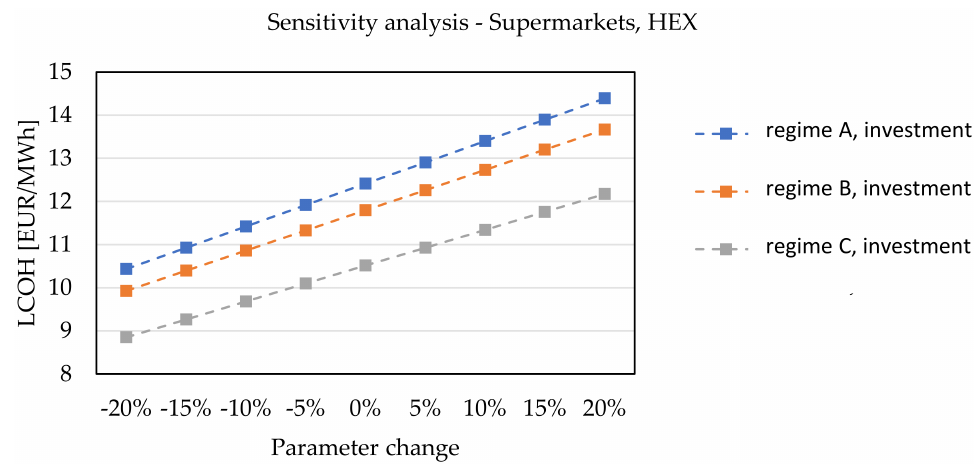
Figure 23. Sensitivity analysis for different DH network temperature regimes—supermarkets waste heat, utilization technology heat